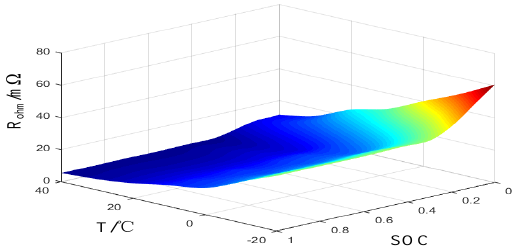
Figure 2. Relationship among the measured R ohm , SOC, and T .